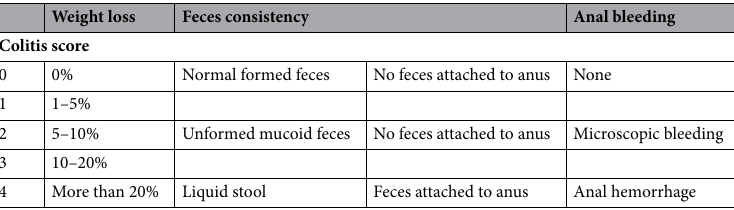
Table 1. Coliti score. Add the above 3 values and divide by 3. 0: Healthy, 4: Colitis maximum active